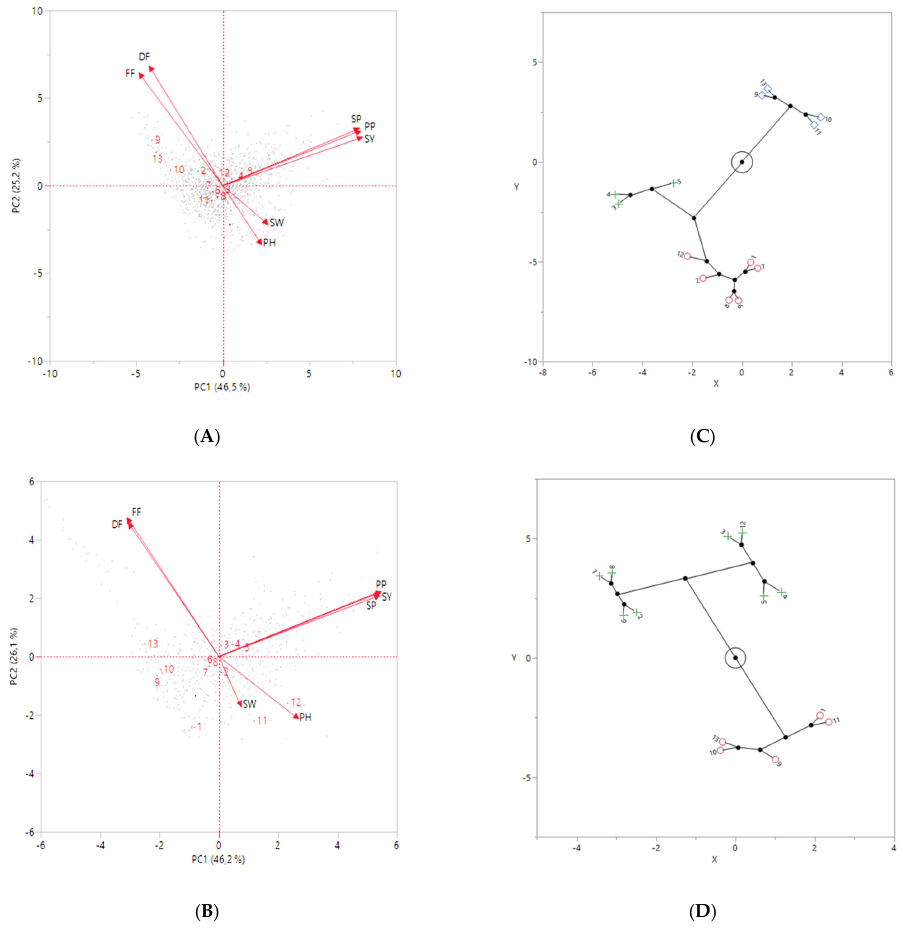
Figure 6. The principal component analysis (PCA) for agro-morphological traits with compound- leafed, simple-leafed chickpeas, parents, and checks in 2019 ( A ) and 2020 ( B ). Constellation plot of compound-leafed, simple-leafed chickpeas, parents, and checks constructed using Ward’s method based on hierarchical cluster analysis (HCA) in 2019 ( C ) and 2020 ( D ). Different colors (blue, green, and red) indicate distinct groups. The numbers in the figures represent: (1) Sierra, (2) CA 2969, (3) Compound-leafed and single-podded, (4) Compound-leafed and double-podded, (5) Compound- leafed and multi-podded, (6) Simple-leafed and single-podded, (7) Simple-leafed and double-pod- ded, (8) Simple-leafed and multi-podded, (9) ILC 3279, (10) ILC 1929, (11) ICC 12004, (12) ILC 482, (13) ILC 72.